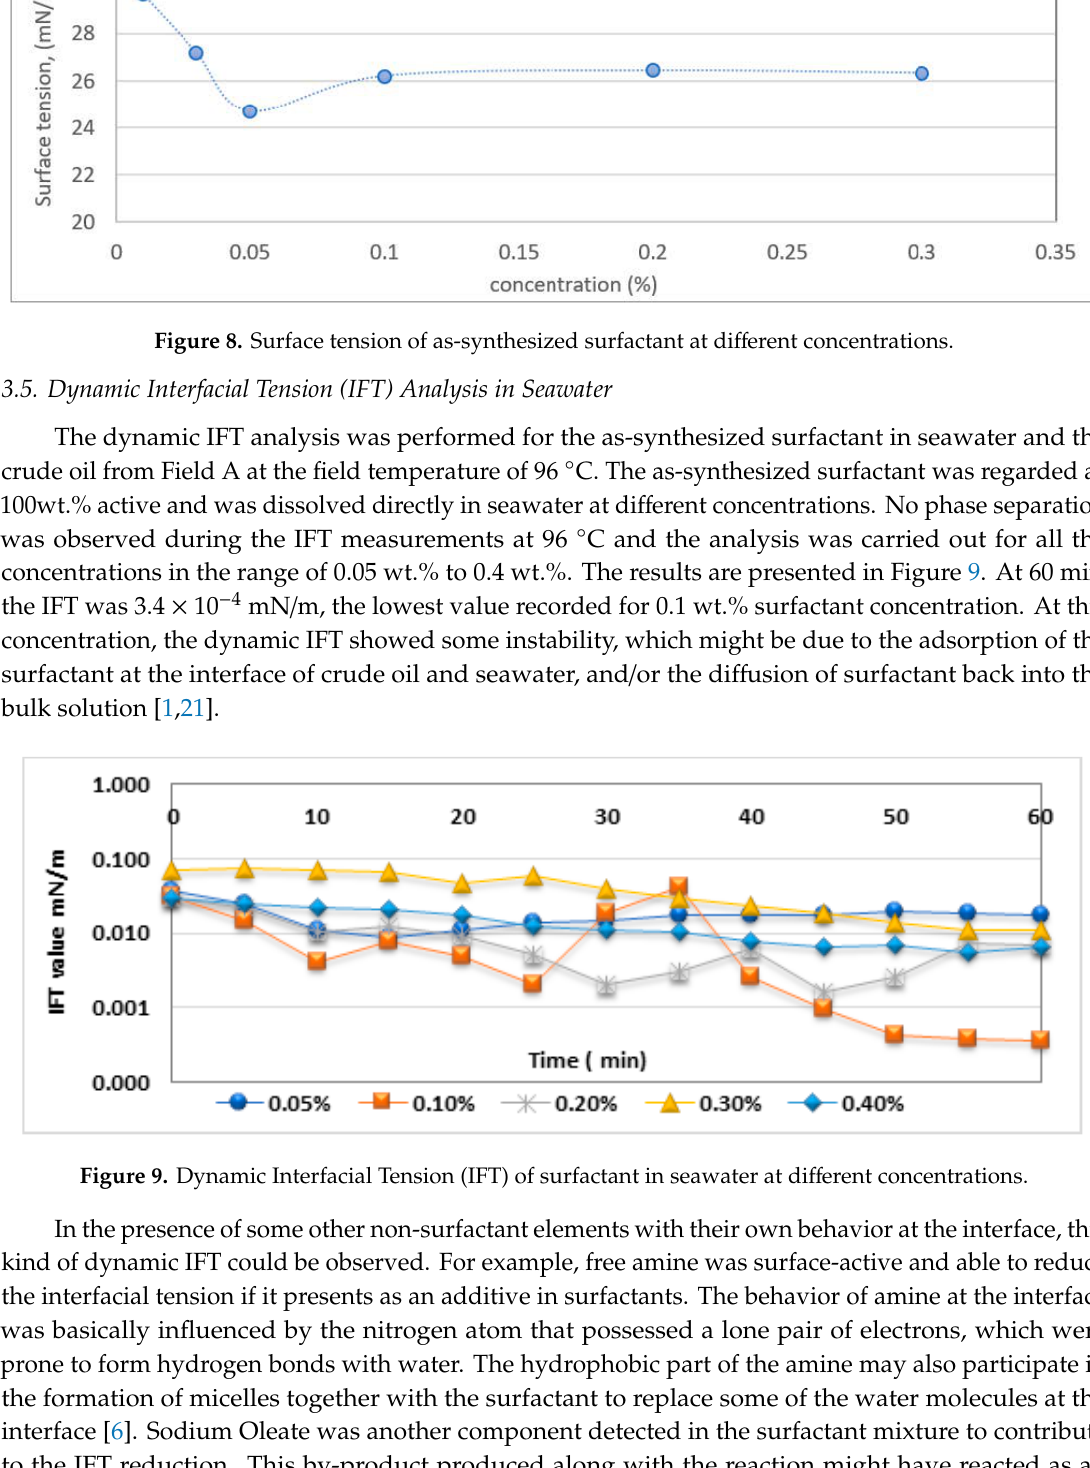
Figure 8. Surface tension of as ‐ synthesized surfactant at different concentrations.